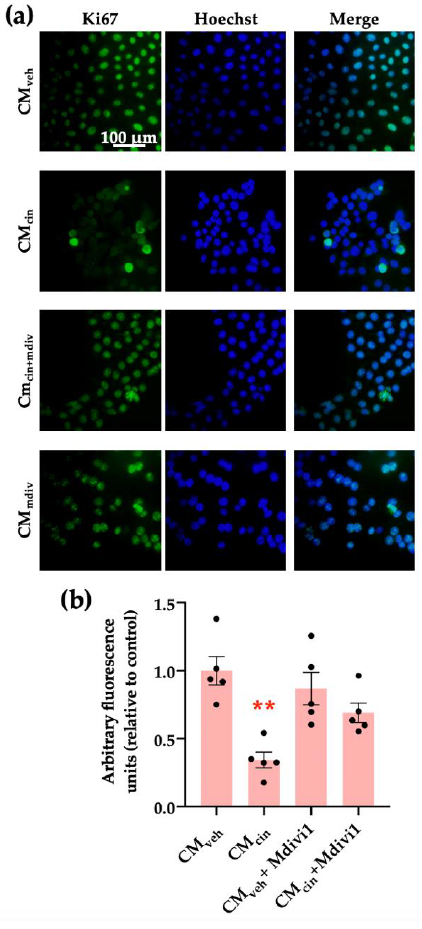
Figure 10. Inhibition of mitochondrial fission prevents the cell cycle arrest induced by CM cin in HepG2 cells: ( a ) representative images of HepG2 cells exposed to the CM veh , CM cin , CM veh + Mdivi1, and CM cin + Mdivi1. Hoechst (blue) was used to identify the nuclei and anti-Ki67 antibody (green) to evaluate the nuclear localization of Ki67 (scale bar = 100 μm); ( b ) quantification of total Ki67 immunofluorescence. Each dot represents an individual experiment ( n = 5). ** p < 0.01 versus the control, Friedman’s test, and Dunn’s post-hoc test.